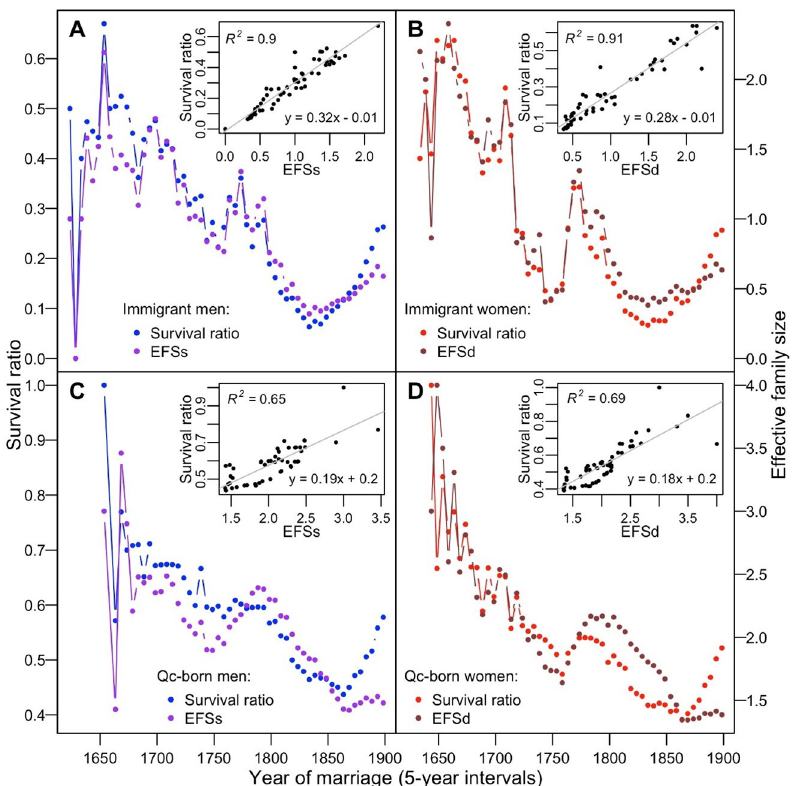
Fig 3. Correlation between effective family size and survival ratio. Overlapping plots of total EFSs and EFSd and their survival ratios for the immigrants ( A and B ) and the Quebec-born lineages ( C and D ). Their correlation plots are shown in the